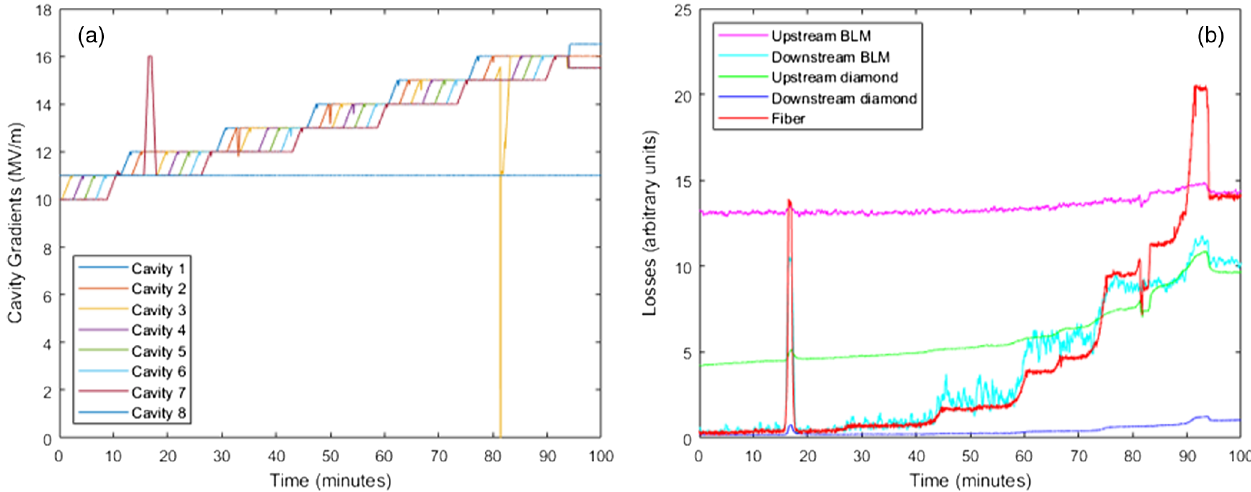
FIG. 16. (a) Gradients in the eight cavities of the cryomodule. The gradients, except in cavity 8, were stepped sequentially by 1 MV = m. Cavity 7 had an upward spike at t ¼ 16 . Cavity 3 briefly dropped out at t ¼ 81 . (b) Losses from field emission picked up by five detectors. Only the fiber was sensitive to the sudden changes in both cavities 3 and